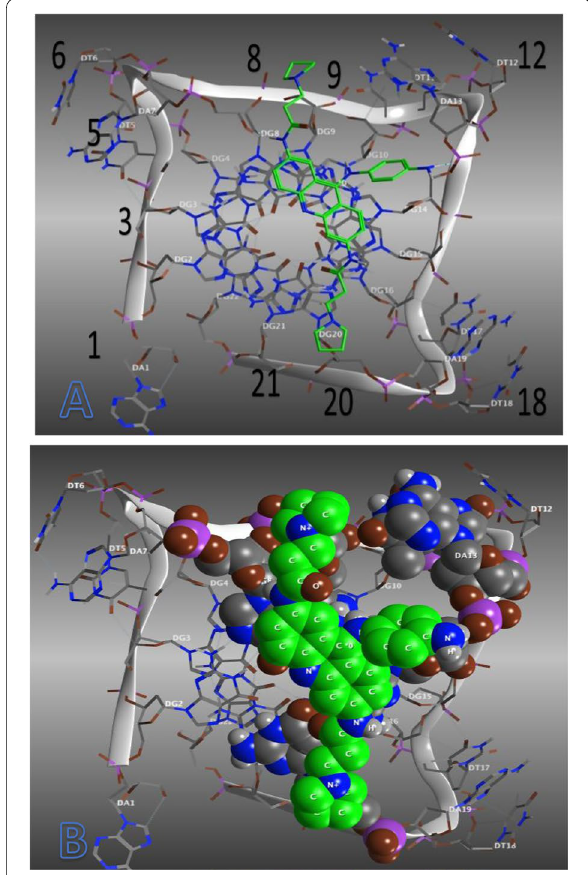
Fig. 16 A 3D depiction of human telomeric G-quadruplex binding with compound 82(green) in stick model. B 3DSpace fill model presentation of telomeric G-quadruplex DNA binding with compound 82